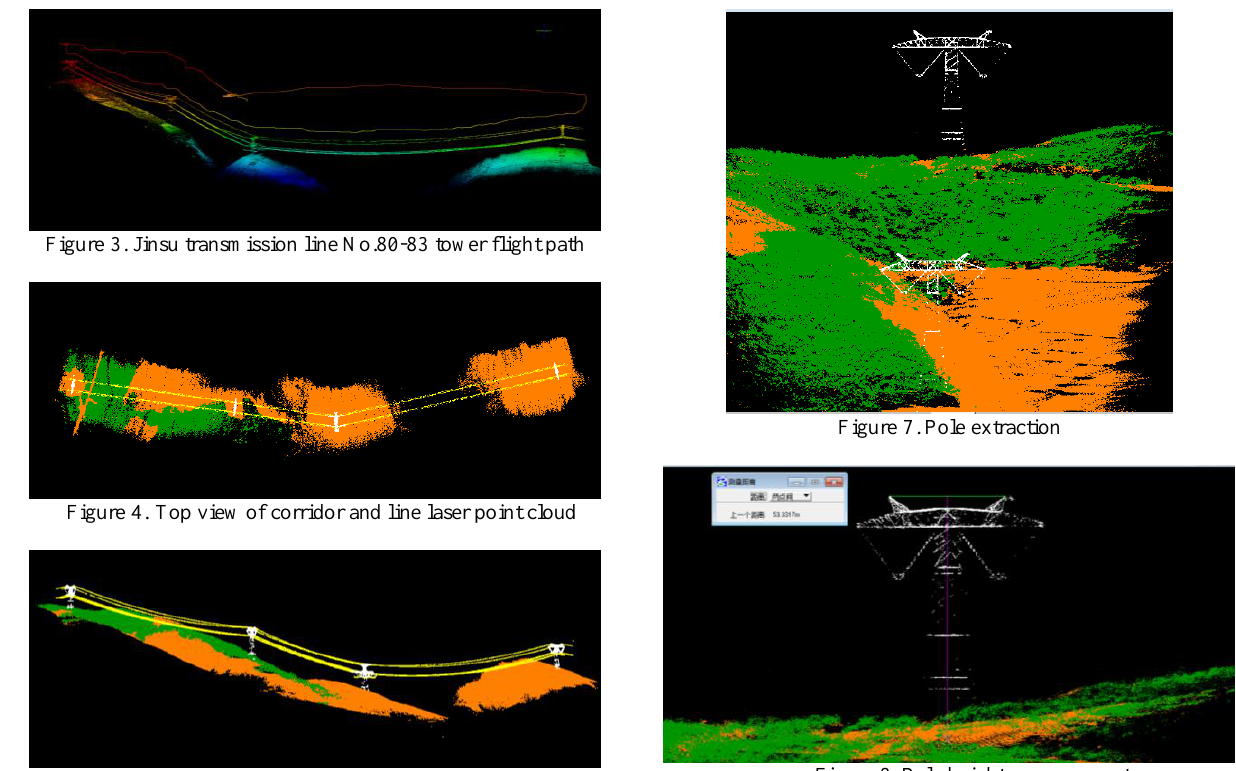
Figure 5. Side view of corridor and line laser point cloud